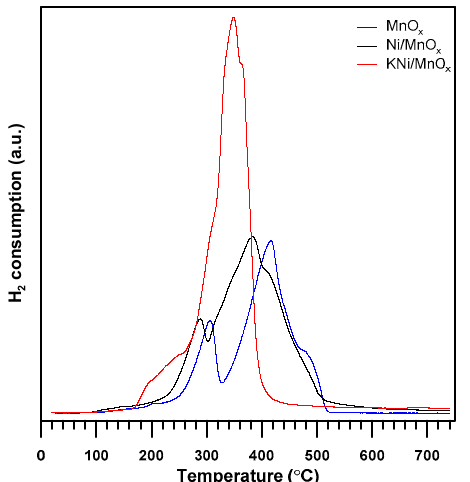
Figure 3. H 2 -TPR profiles of MnO x support and Ni/MnO x and KNi/MnO x catalysts.